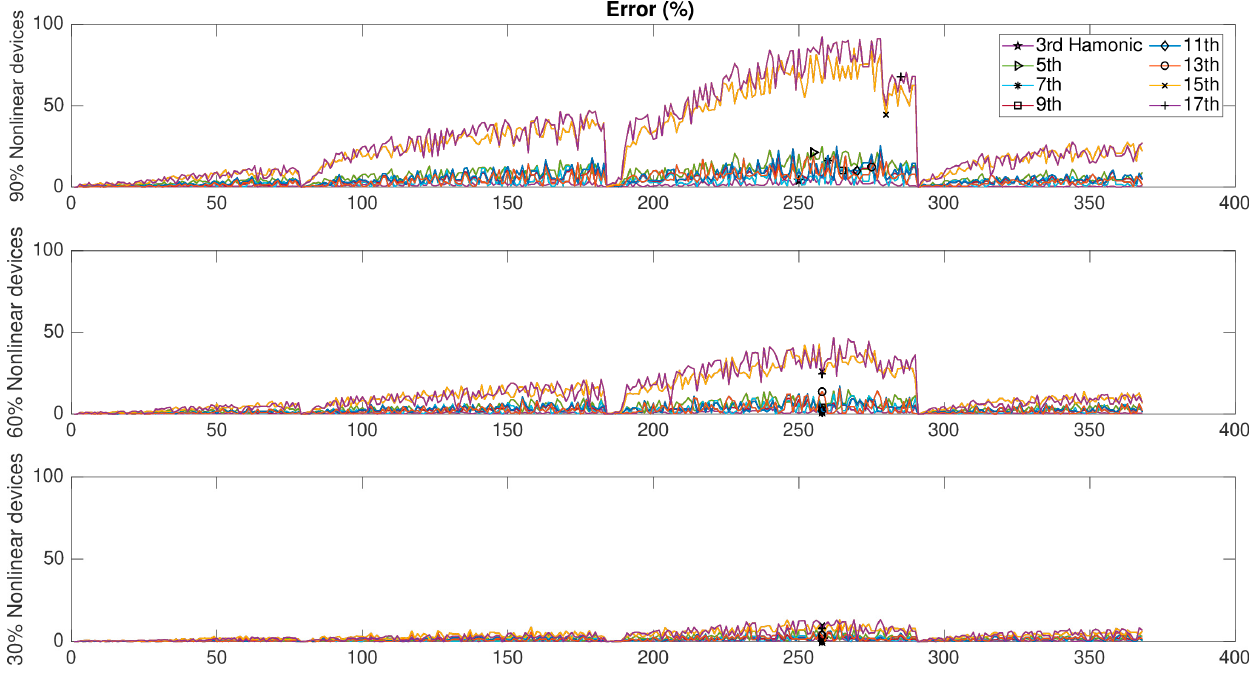
Figure 10. Urban LV network (90%).